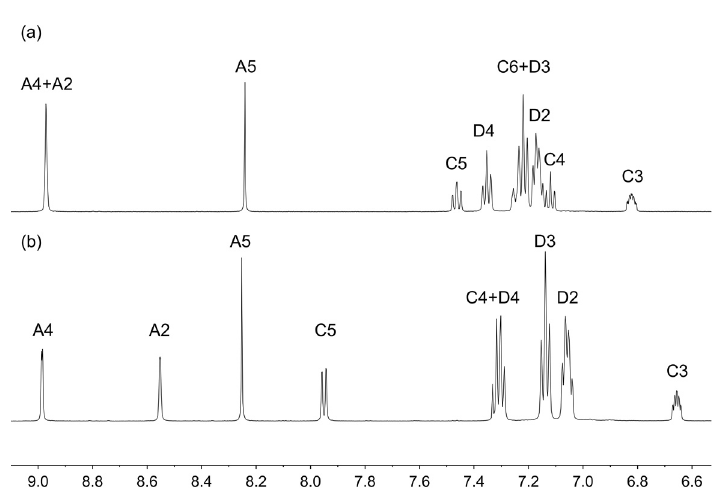
Figure 1. The aromatic region of the 1 H NMR spectra (500 MHz, acetone- d 6 , 298 K) of ( a ) [Cu(POP)(3,8-Br 2 phen)][PF 6 ] and ( b ) [Cu(xantphos)(3,8-Br 2 phen)][PF 6 ]. See Schemes 1 and 2 for atom labels. Chemical shifts in δ /